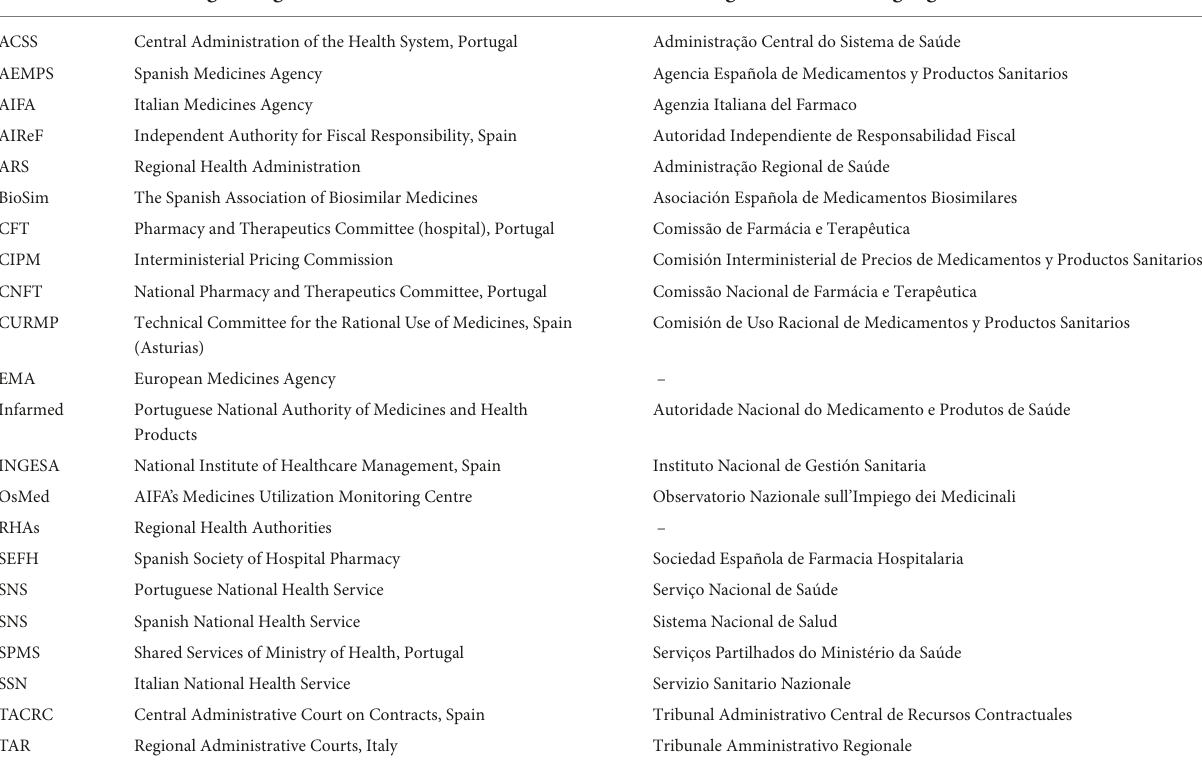
TABLE 1 Glossary of specialized abbreviations and terms used in the